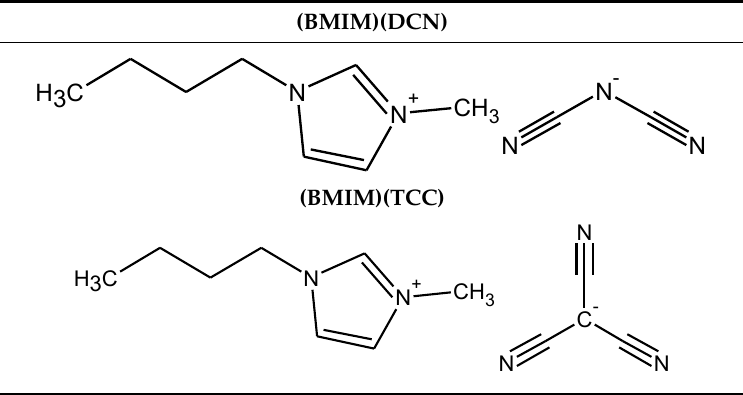
Table 1. Molecular structures of cyano-based ionic liquids. 1-Butyl-3-methylimidazolium dicyanamide